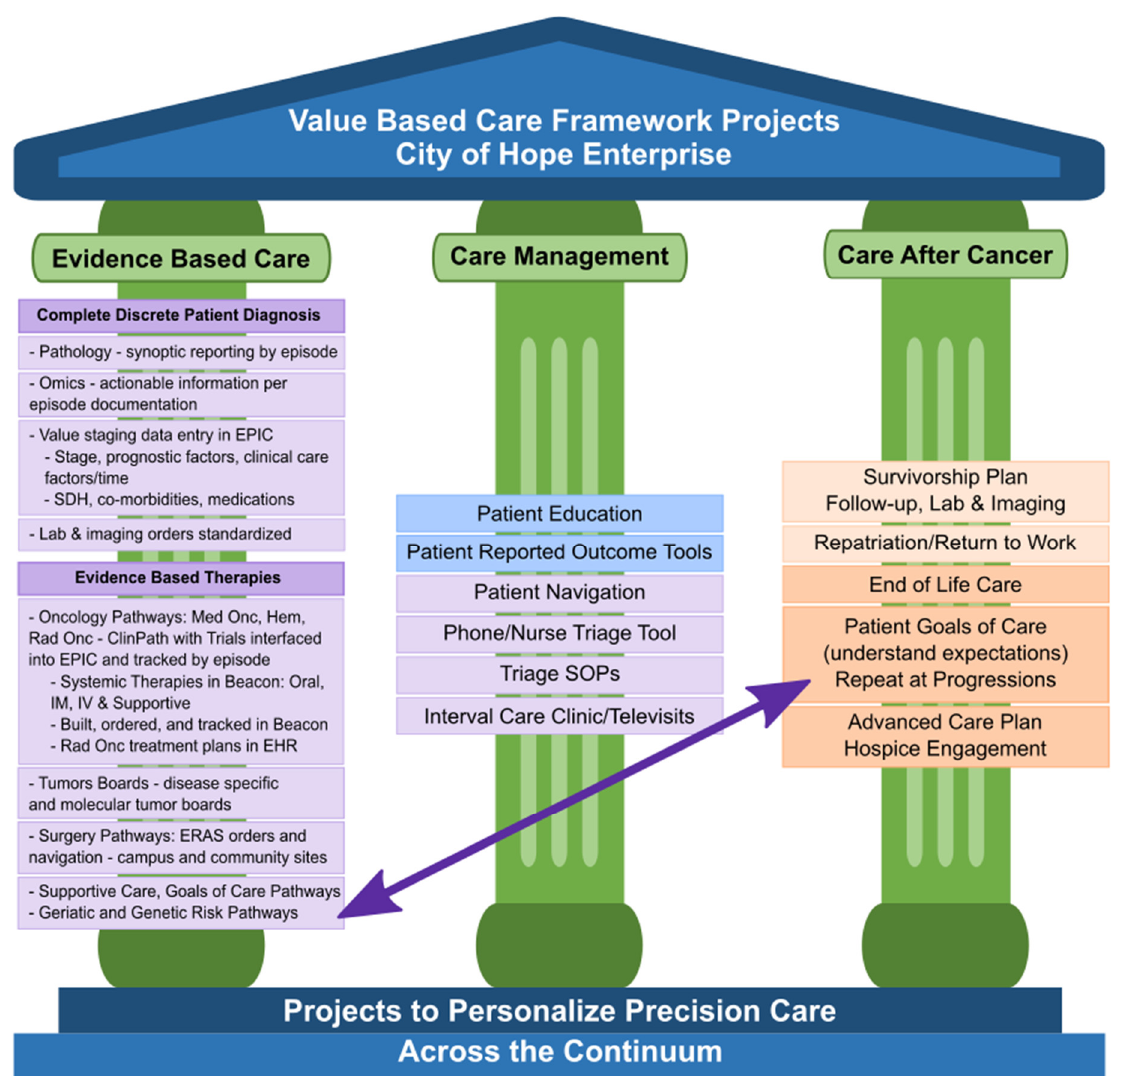
Figure 1. Value-based care framework projects for City of Hope Enterprise: Green represents the three pillars of value- based care: evidence-based care, care management, and care after cancer. The boxes represent categories of projects to facilitate measurable delivery of value-based care. Purple indicates clinician-led projects. Blue indicates patient-focused projects. Orange indicates projects after active therapy or curative therapy, whether in survivorship or end of life. Within the category of complete discrete patient diagnosis are the projects that will help to accomplish this. Omics refers to genomics, proteomics, metabolomics, and microbiome information that impacts a patient’s treatment episode choices and potential outcomes. SDH refers to social determinants of health. Med Onc—medical oncology, Hem—hematology, Rad Onc—radiation oncology. ClinPath is the pathway system by Elsevier (formerly called VIA Pathways). EPIC refers to the EHR. IM—intramuscular, IV—intravenous. EHR—electronic health record. ERAS—early recovery after surgery pathways. SOP—standard operating procedures. Televisits—telephone and televideo visits. The purple arrow indicates that goals of care pathways are incorporated during active therapy as well during in advanced end of life care.